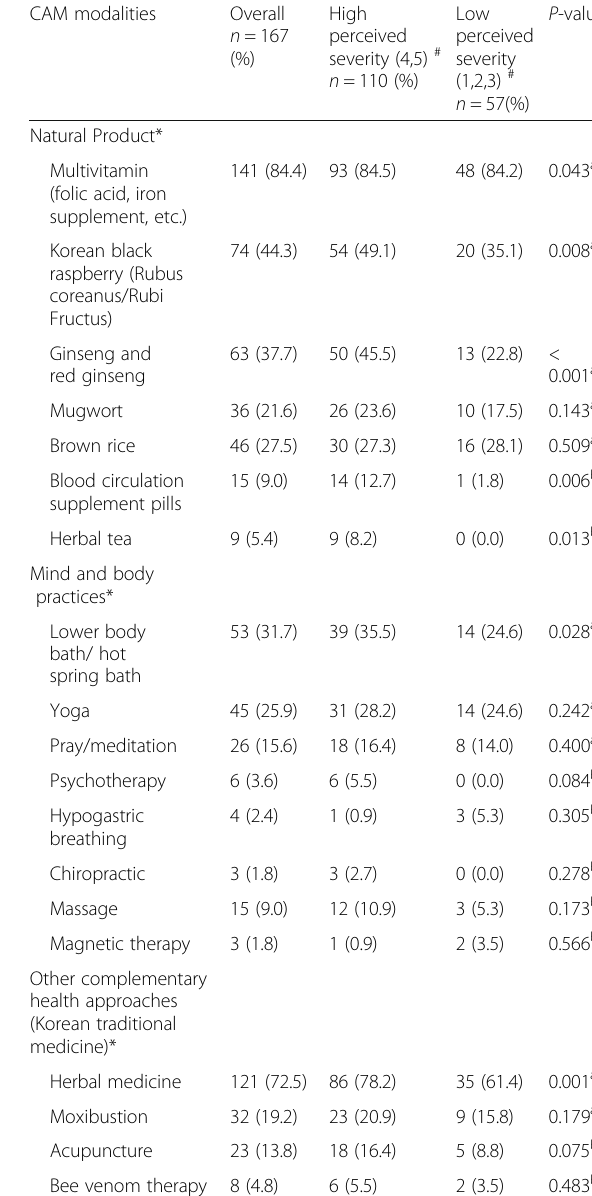
Table 3 Health-related characteristics of respondents ( n = 263) Characteristics